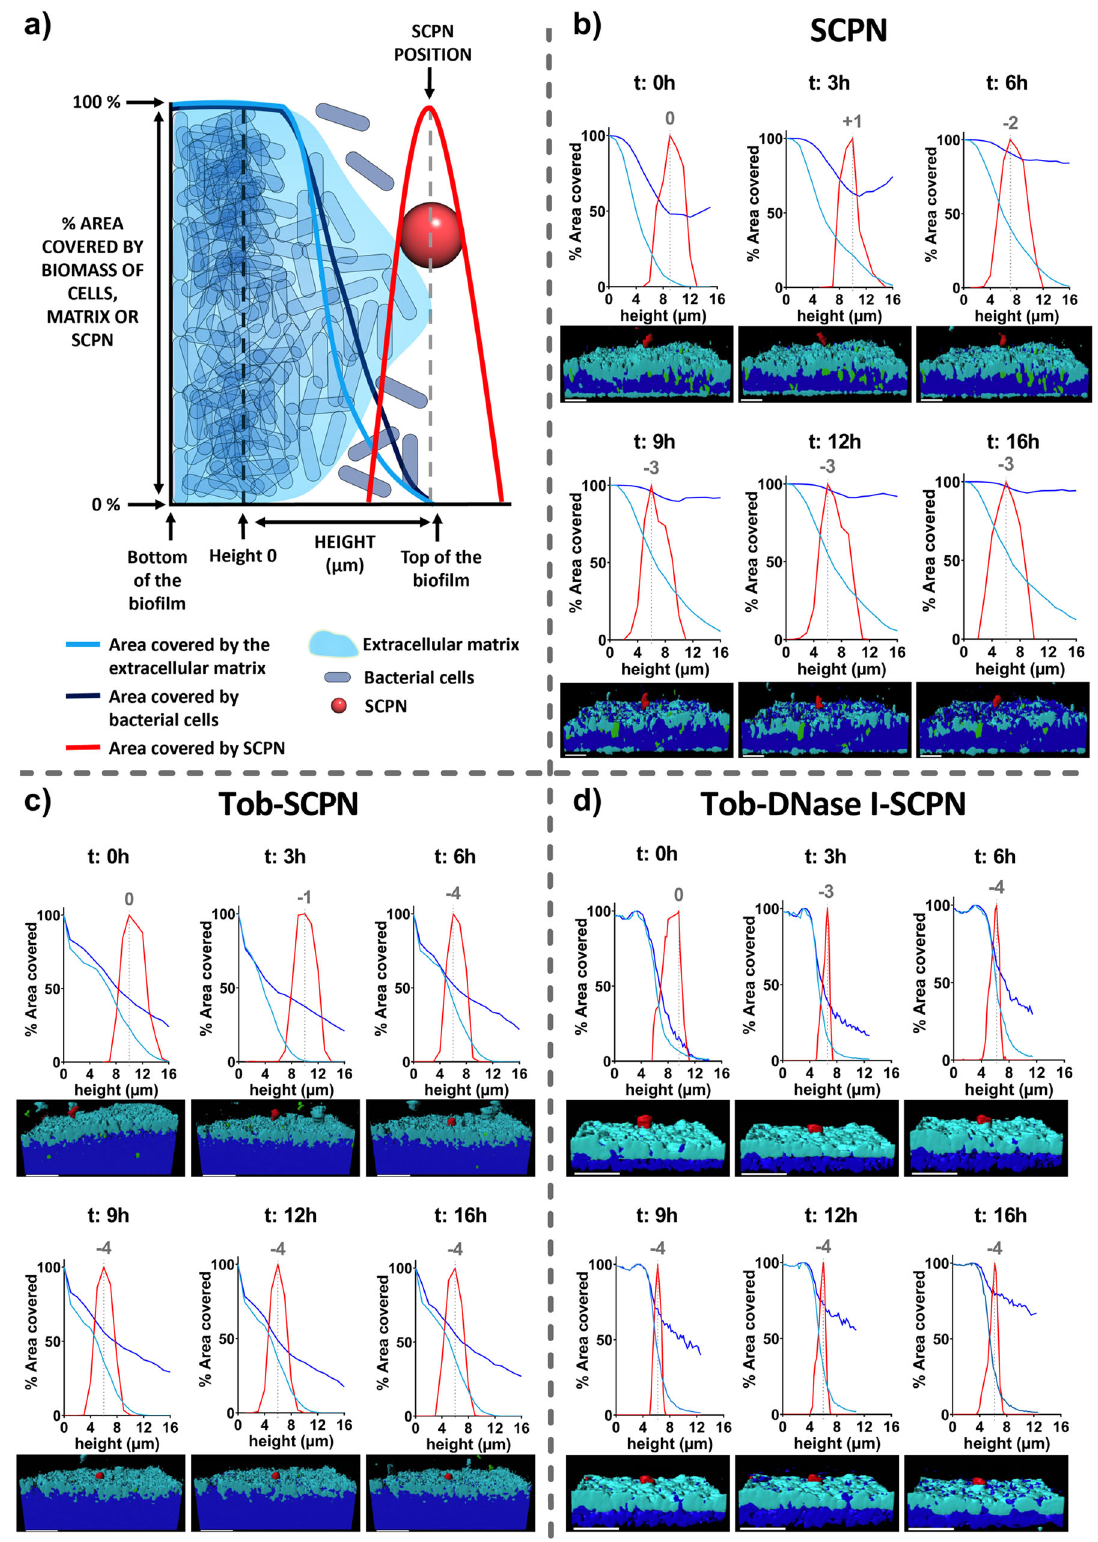
Fig. 5 Tracking of an SCPN aggregate into the P. aeruginosa bio fi lm for 16 h. a Schematic representation of the graphs. b SCPN (without tobramycin and DNase I), ( c ) tobramycin-containing nanoparticles and ( d ) nanoparticles encapsulating both tobramycin and DNase I. Lines represent the area percentages occupied in layers by the cells (dark blue line), matrix (light blue line), and nanoparticles (red line) at different times. The height of 0 on the x-axis is taken as the moment when the bio fi lm started to decrease. The area values covered in the nanoparticle were normalized by assigning 100% at the highest percentage. Gray numbers represent movement (in µm) of the nanoparticle in the bio fi lm. A 3D representation view of the bio fi lm is illustrated for each time. The scale bar represents 10 µm. The results presented in this fi gure are representative microscopy images of an experiment repeated at least twice with similar